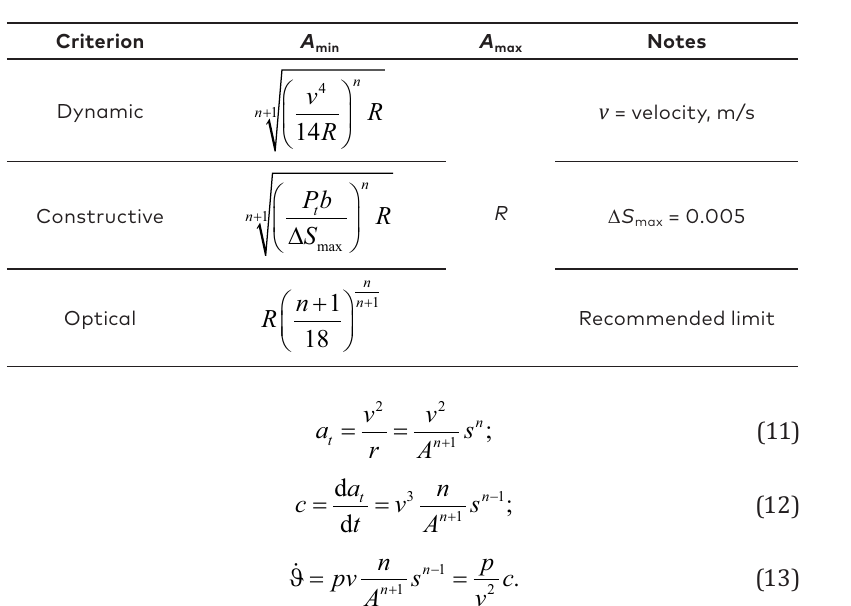
Table 2. Limitations to the GCS scale parameter